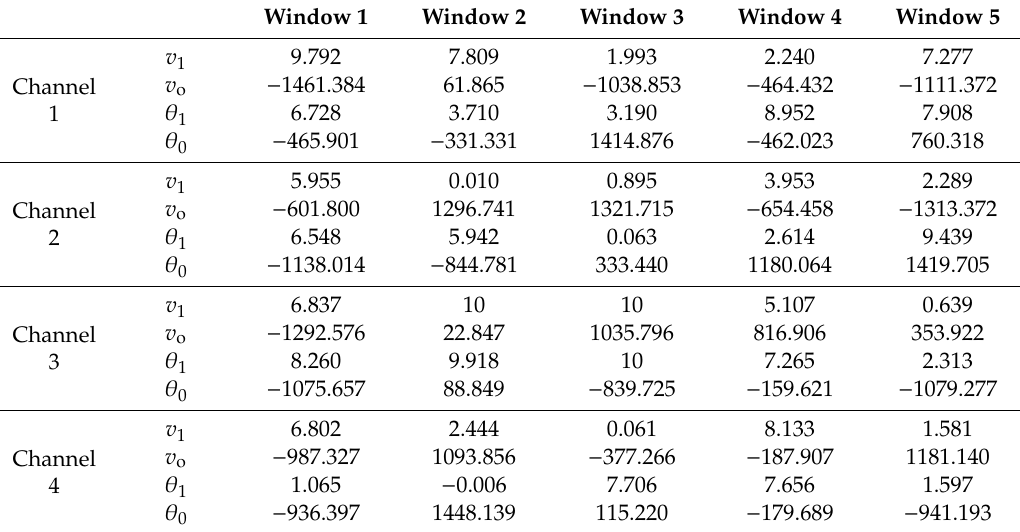
Figure 5. Classification performance improvement using GENETIC optimization. Table 4. Typical, optimal parameters computed for the channel group G1 for k = 5.